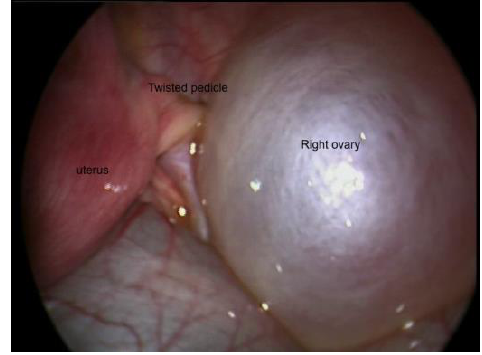
Figure 2: Twisted right ovarian